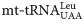
Modification of the wobble uridine (U34) in mitochondrial and bacterial tRNAs.Schema of the U34 modification pathways in human and yeast mt-tRNAs and Escherichia coli tRNAs (A) and A. suum mt-tRNAs (B). In A, proteins GTPBP3, MTO1, and TRMU (also named MTU1) from humans, and MSS1, MTO1, and MTU1, from yeast, are orthologous of the bacterial MnmE, MnmG and MnmA proteins, respectively. Taurine (humans) and glycine (E. coli and yeast) are used to introduce the τm and cmnm groups into position 5 of U34. In B, MTCU-1, MTCU-2 and MTTU-1 are the nematode orthologues of GTPBP3, MTO1, and TRMU, respectively, and their roles are inferred from studies of the E. coli and yeast proteins. The fractions of A. suum modified mt-tRNAs, according to the study by Sakurai et al. [28], are indicated below the schema. Note that mt-tRNAGlu, mt-tRNALys and mt-tRNAGln are fully modified at position 5 but lack thiolation at position 2, whereas most mt-tRNAUAALeu (~90%) is modified at both positions (2 and 5), and about 50% of mt-tRNATrp molecules do not contain any modification at the U34.